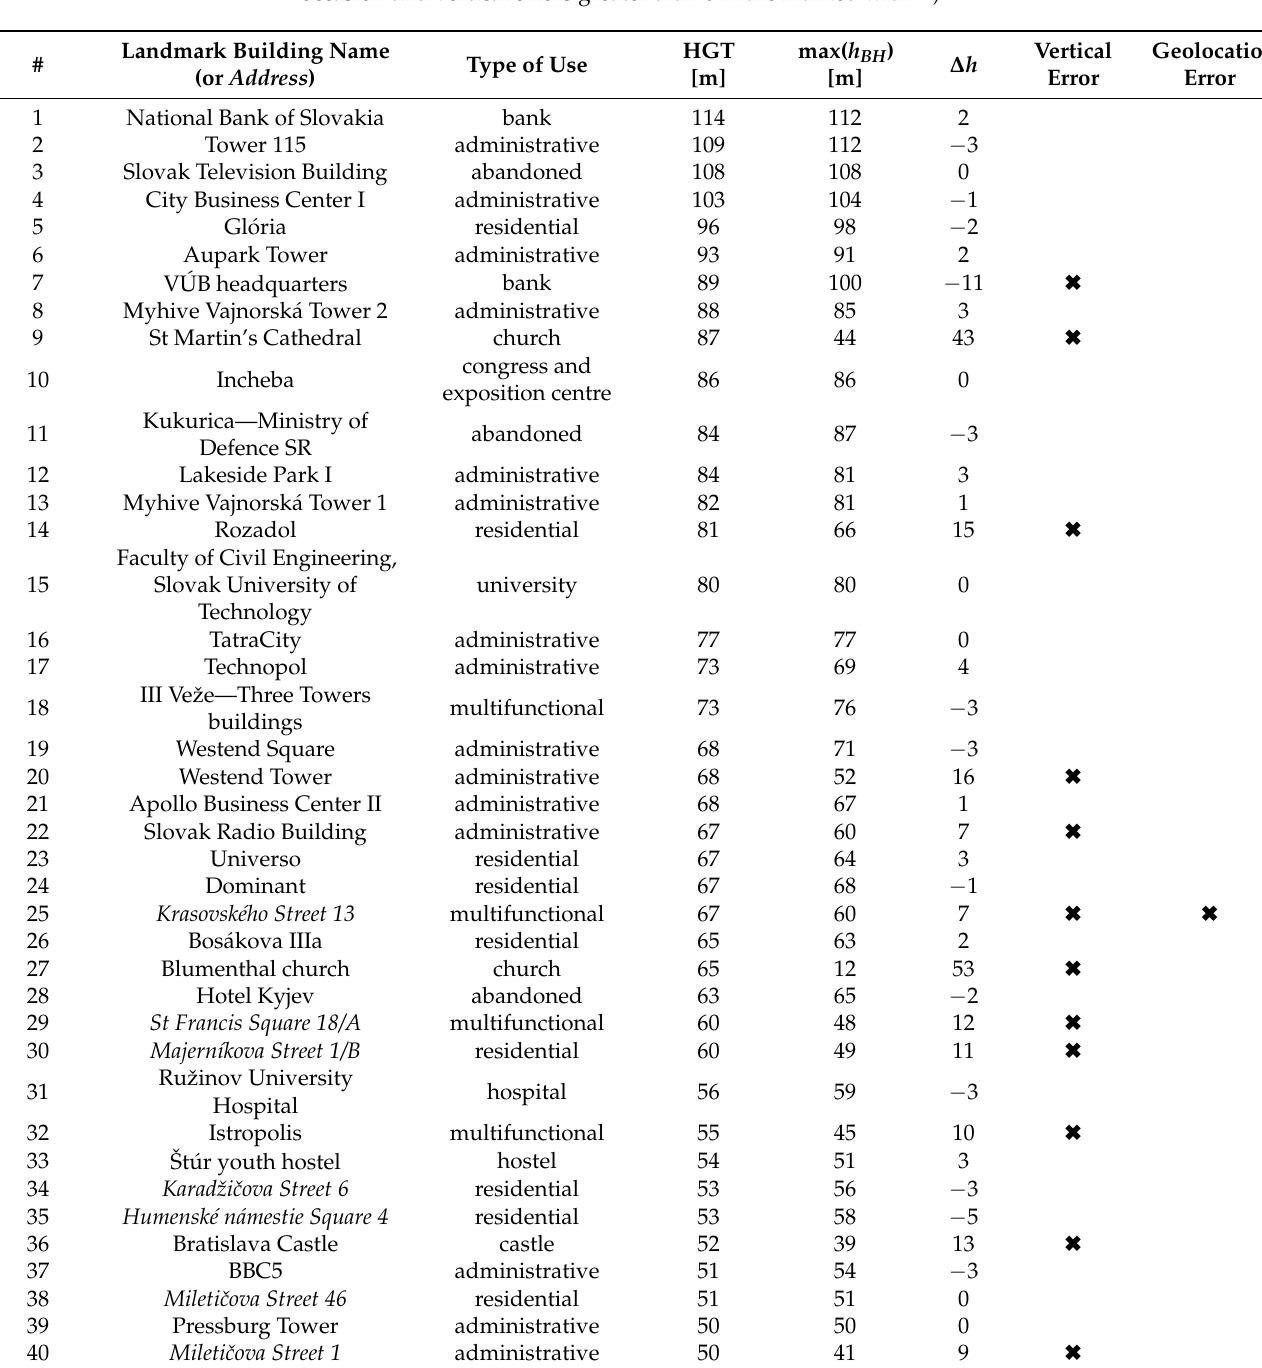
Table 4. Building height comparison for the forty highest buildings in 2012 in Bratislava (the address is indicated in italics in case of building name unavailability; a geolocation error identified on one occasion and vertical errors greater than 6 m are marked with (cid:54)